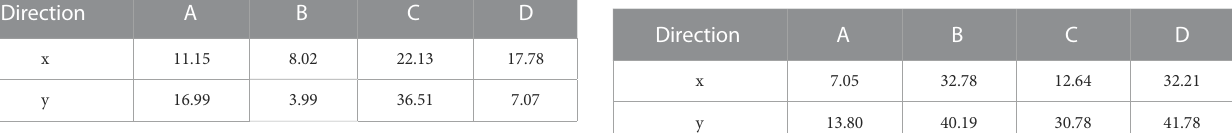
TABLE 7 Increase of residual stress with ultrasonic power from 240 W to 300 W